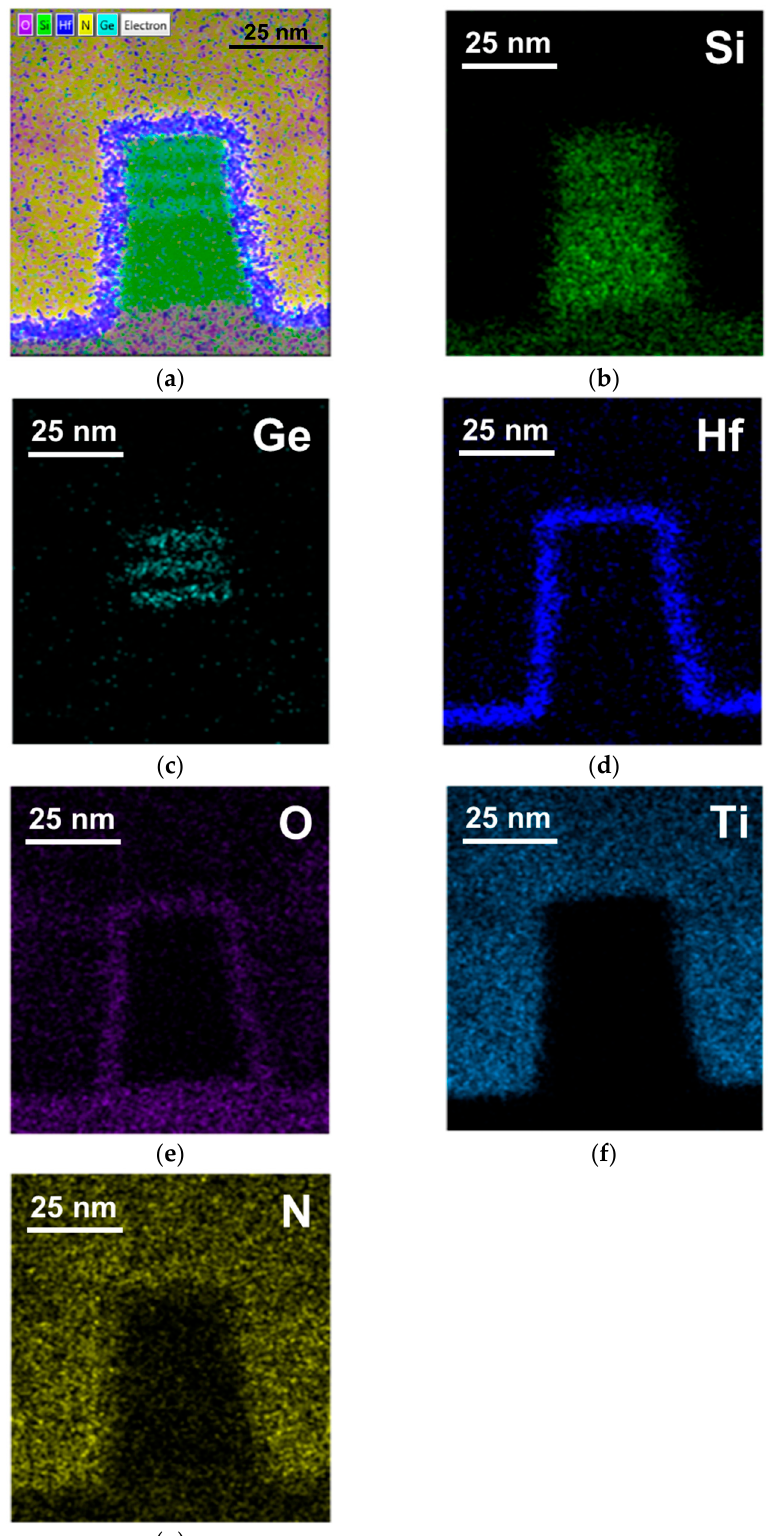
Figure 3. ( a ) EDX mapping of the Si 0.8 Ge 0.2 /Si SL FinFET and ( b – g ) the element distribution with clear separation between the Si 0.8 Ge 0.2 and Si epitaxial layers. To verify the crystallinity of the Si 0.8 Ge 0.2 /Si SL heterostructure, nanobeam di ff raction (NBD) analysis was performed, with a focus on each layer. The NBD pa tt erns according